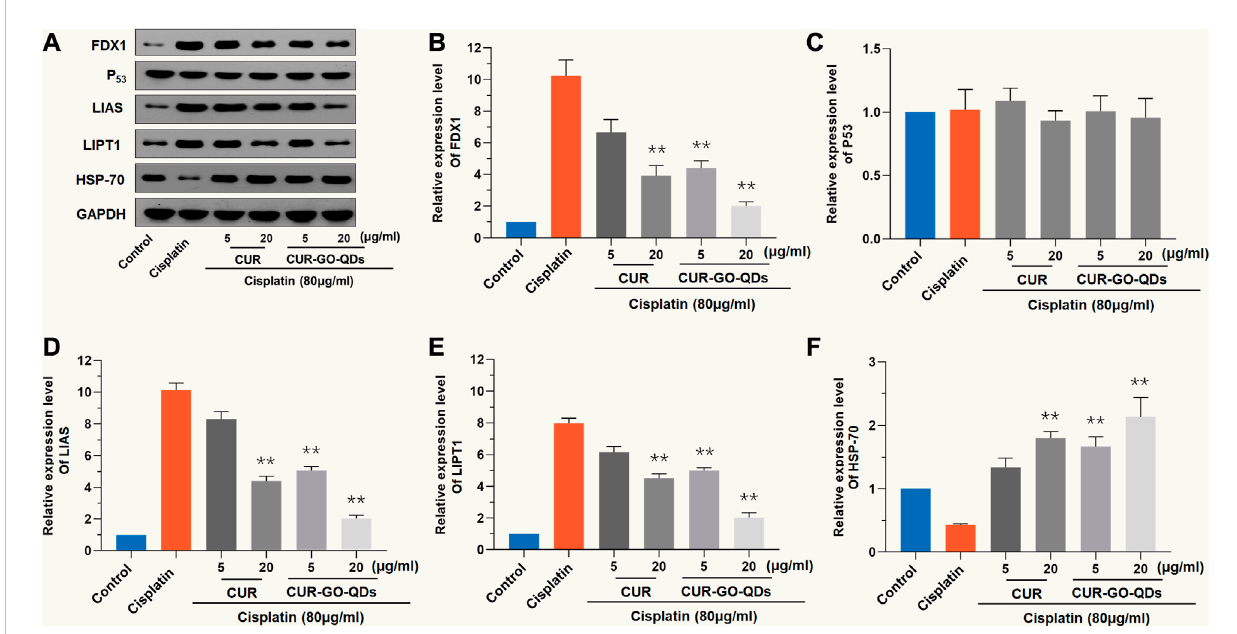
FIGURE 4 CUR/GOQDs alleviatesCIS-inducedcuproptosis. CIS(80 μ M,24 h)inducedcuproptosis ofOC1cells afterpretreatmentwithCUR,orCUR/GOQDs (5and15 μ g/mL)for4 h. (A) Westernblotwithanti-FDX1,anti-P53,anti-LIAS,anti-LIPT1andanti-HSP-70antibodies. (B – F) Quanti fi cationofWesternblot in (A) . ** p < 0.01, as compared to CIS.